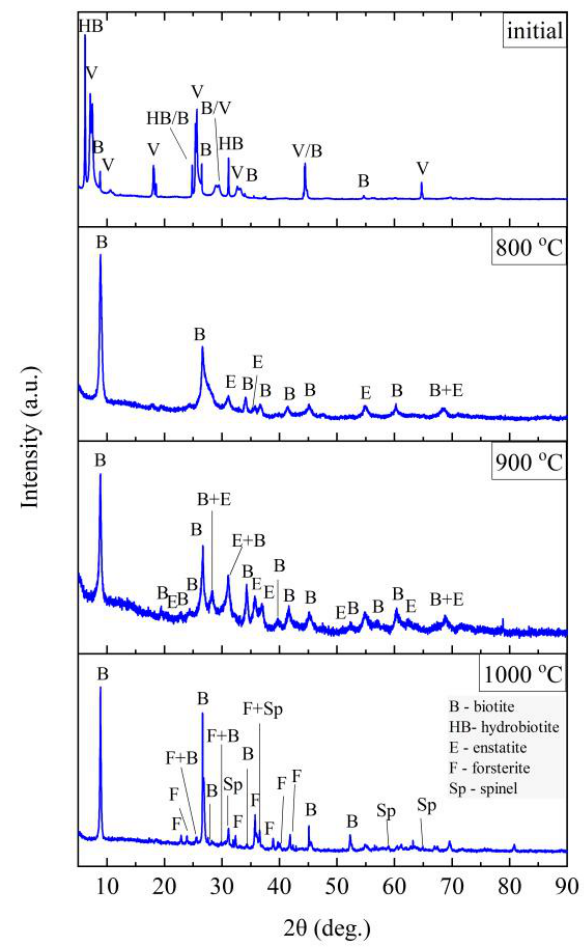
Figure 15. XRD diffractograms for vermiculite (V).